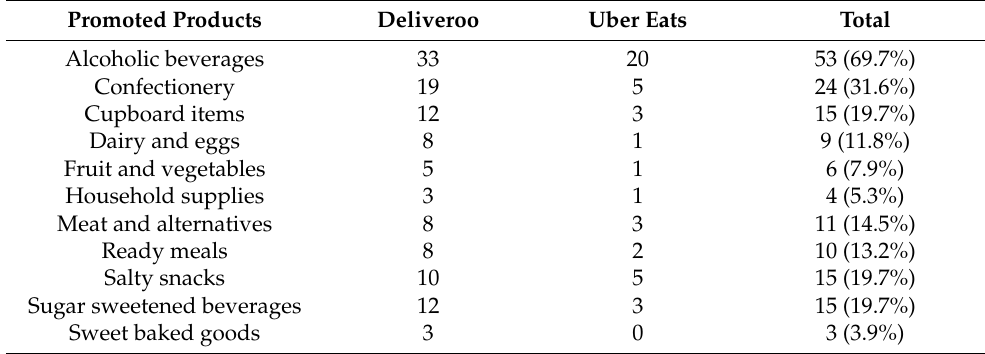
Table 4. Products shown on the cover images of grocery businesses on delivery platforms. Businesses typically featured more than one product in their cover